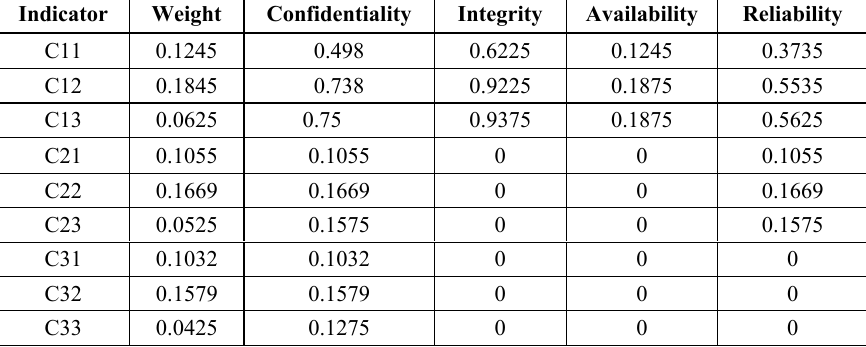
Table 3. Importance degree from the password cracking evaluation index to the attribute